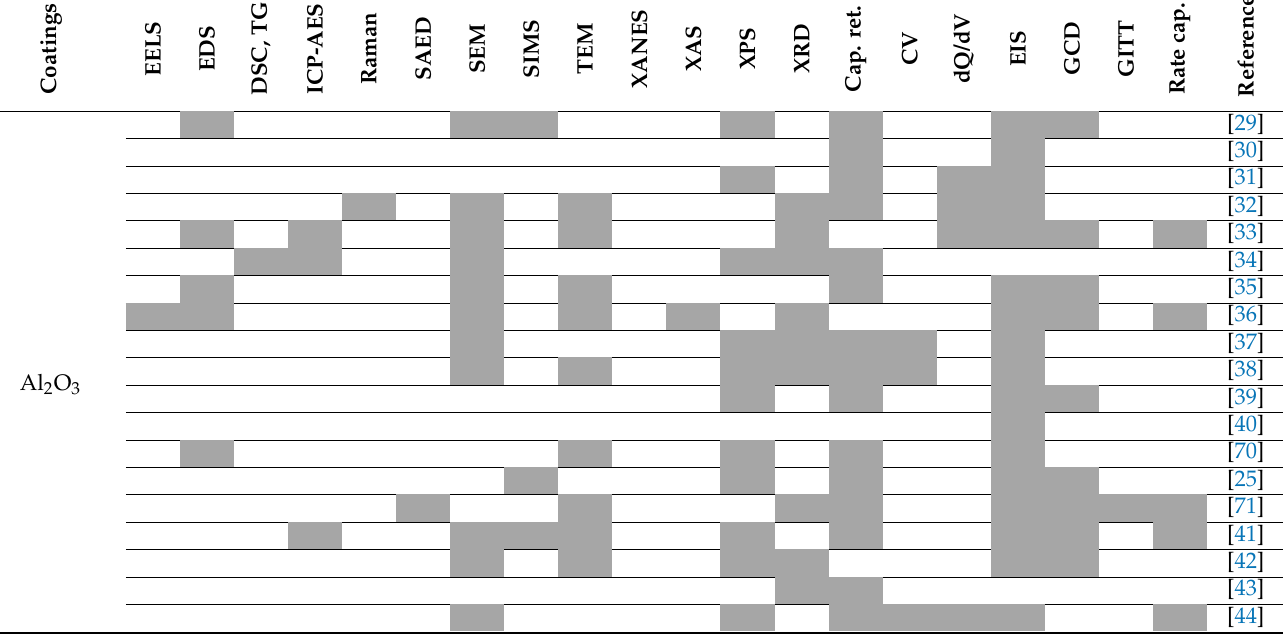
g s EELSE n ti a o C